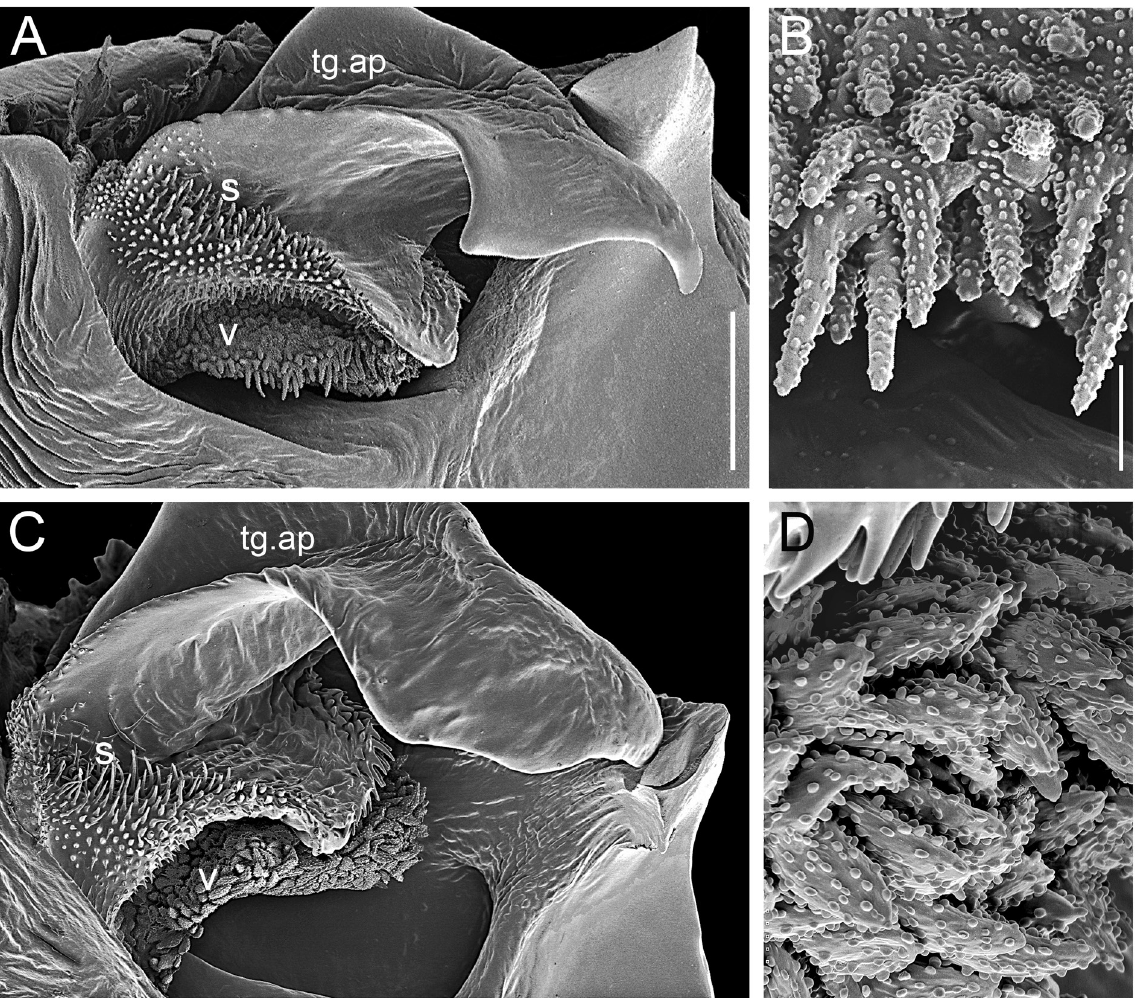
Fig. 6. Tegulum of left male palp with tegular apophysis ( tg.a ). Basal part and lower branch of tegular apophysis with spinulae ( s ) and verrucose outgrows ( v ), the latter enlarged in B and D. — A – B . Wadicosa cognata sp. nov . , from Kenya, Lake Magadi. — C – D . W. fidelis (Pickard-Cambridge), from Spain. Scale bars: A, C = 100 µm, B, D = 10